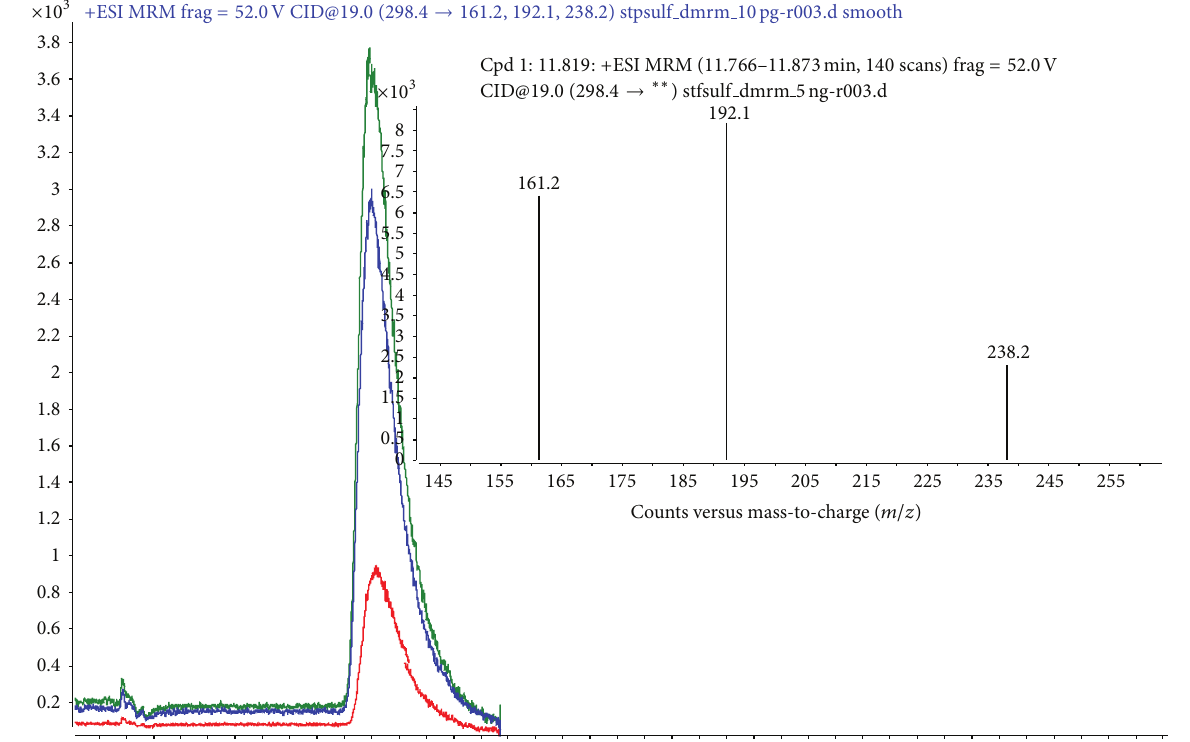
Figure 4: Extracted ion chromatogram (XIC) and SRM-spectrum of 10 pg of stepharine transitions 298.4 1+ → 161.2 1+ , 192.1 1+ , 238.2 1+